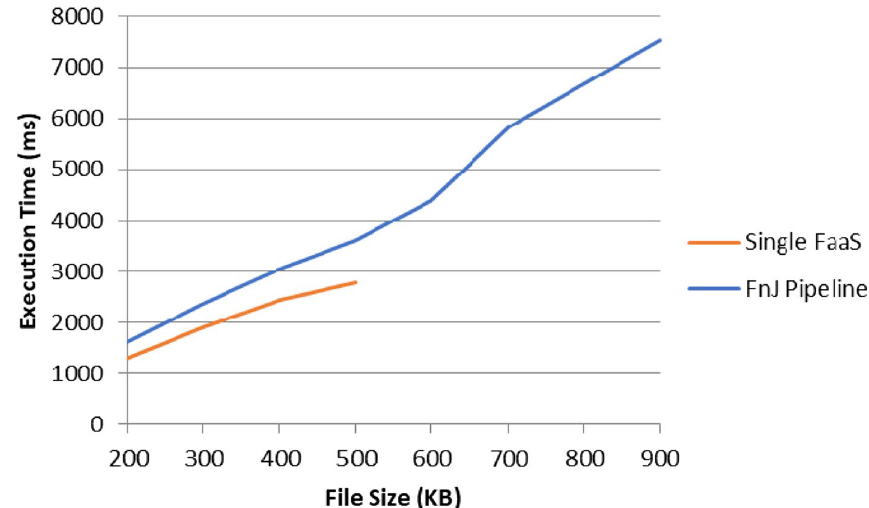
Fig. 9 Executions Results of Single Lambda vs FnJ